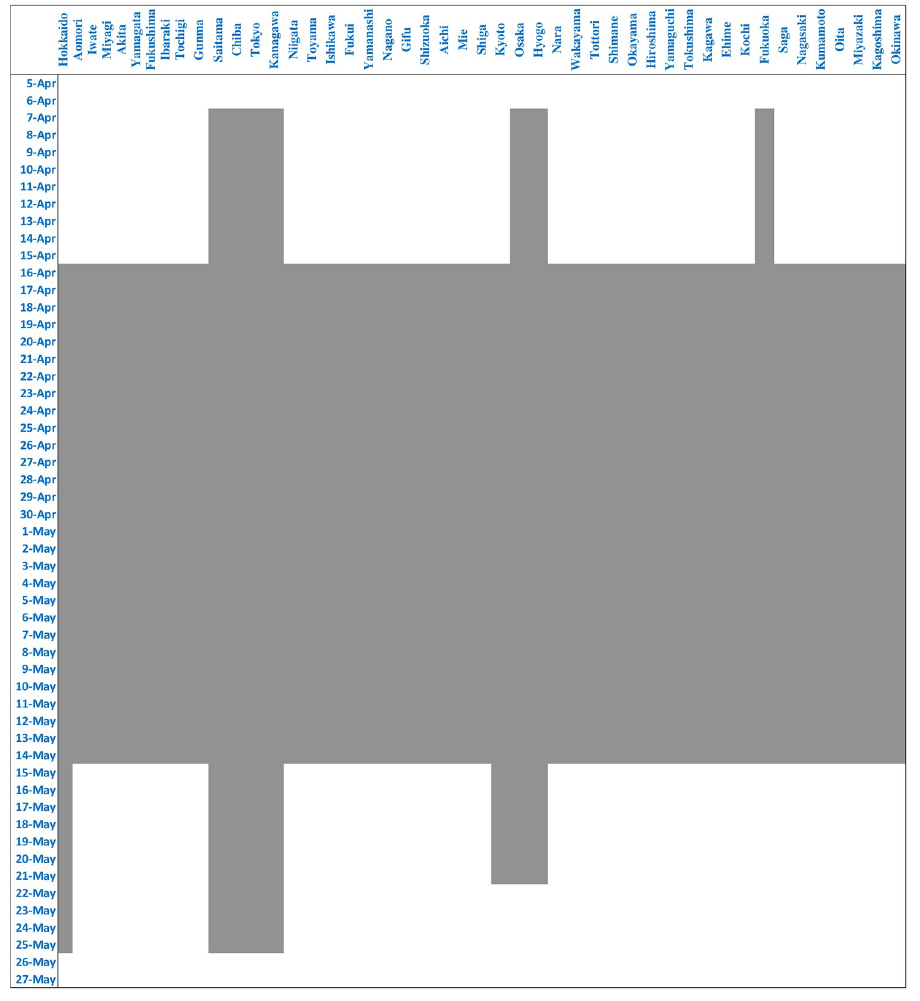
Fig 6. Start and end of state of